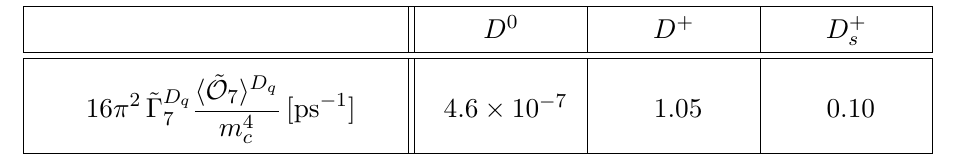
Table 10 . Dimension-seven contributions to D -meson decay widths (see eq. (2.72)) in ps − 1 within VIA in the kinetic mass